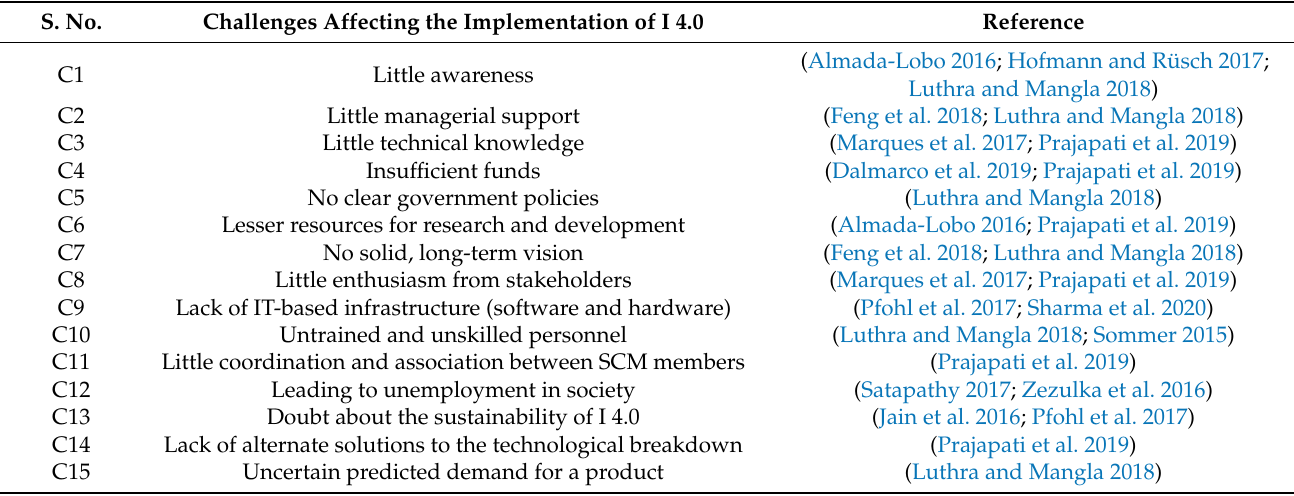
Table 1. Challenges affecting the implementation of I